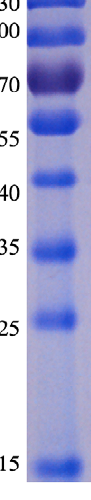
mcrBC) D lacX74 deoR endA1 araD139 D (ara, leu) 7697 rpsL recA1 nupG Q 80dlacZ D M15 [ l c1857 (cro-bioA) ,. Tet] (cro-